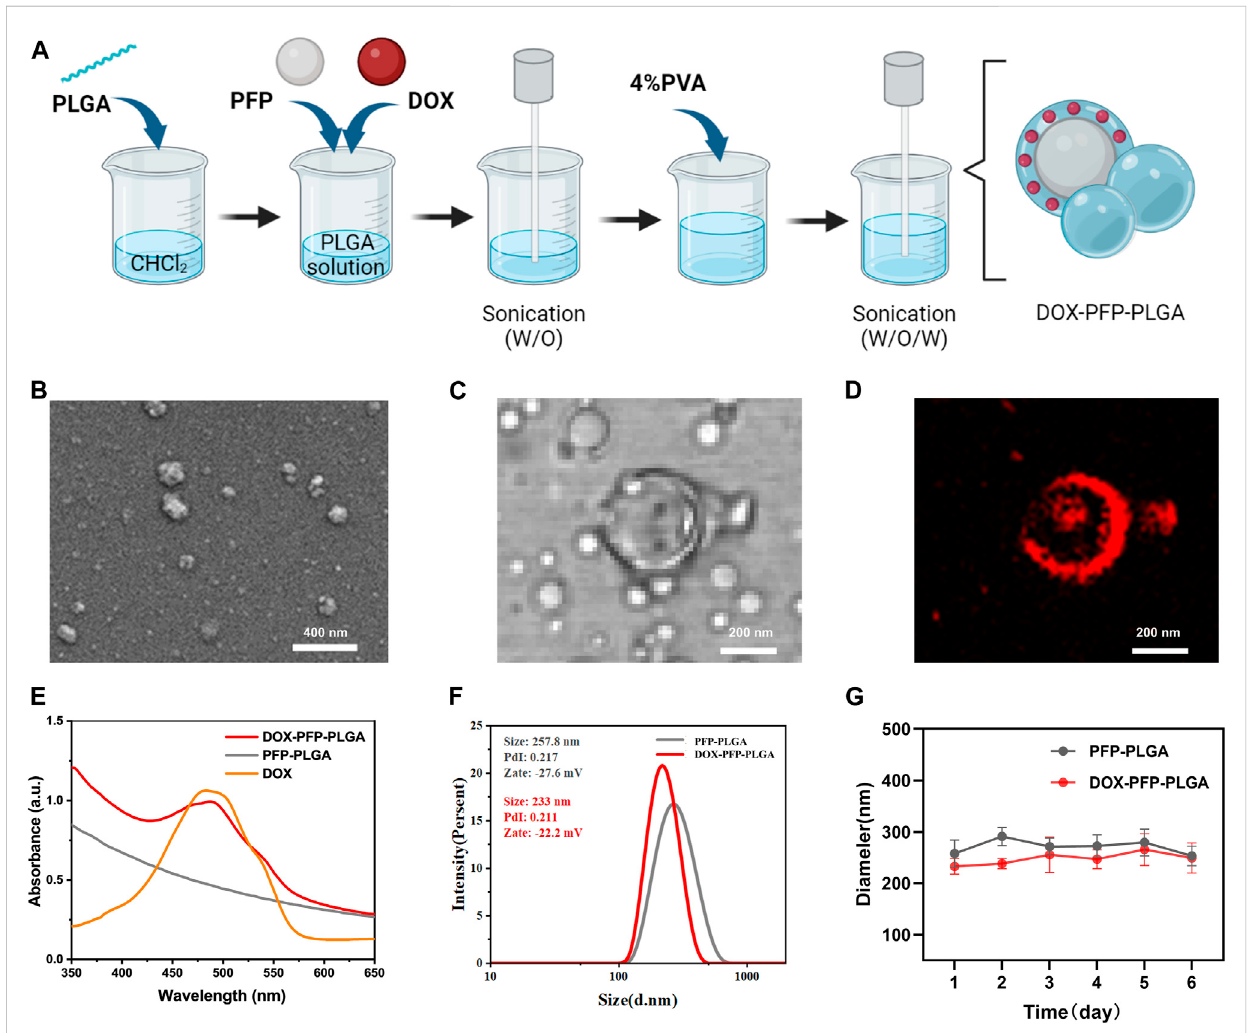
FIGURE 2 Synthesis and characterization of PFP-PLGA and DOX- PFP-PLGA. (A) The schematic diagram of the synthesis of DOX-PFP-PLGA (created with Biorender.com). (B) TEMimageshowedthemorphologyofPFP-PLGA. (C,D) CLSMimageofDOX-PFP-PLGA. (E) UV-visabsorptionspectraofDOX-PFP- PLGA, PFP-PLGA, and DOX. (F) The size distribution and zeta potential of PFP-PLGA and DOX- PFP-PLGA. (G) The size distribution with prolonged time duration of PFP-PLGA and DOX-